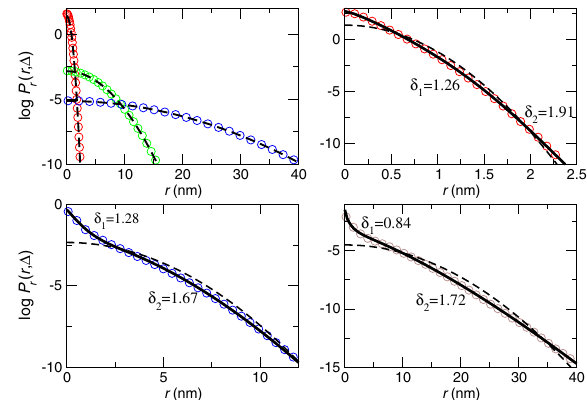
FIG. 4. Radial propagator P r ð r; Δ Þ for DPPC lipids in protein- poor and protein-rich membranes. In all cases the dashed and solid lines, respectively, represent the fitting curve to the r Þ ¼ simulation result: (dashed) Gaussian propagator F G ð 2 (cid:2) , (solid) non-Gaussian propagator F c − ð r= 2 σ r Þ ¼ 1 exp ½ 1 Þ NG ð δ 1 (cid:2) þ c δ 2 (cid:2) , where the annotated δ − ð r= 2 σ − ð r= 2 σ c 1 exp ½ 1 Þ 2 exp ½ 2 Þ values are the fit values. (Top left) The protein-poor case with Δ ¼ 1 ns (red), 10 ns (green), and 100 ns (blue). The other panels are for the protein-rich case with Δ ¼ 1 ns (top right), 100 ns (bottom left), and 1000 ns (bottom right). The two-component Gaussian fit to the P is supplemented in Fig. S7 in Supplemental Material